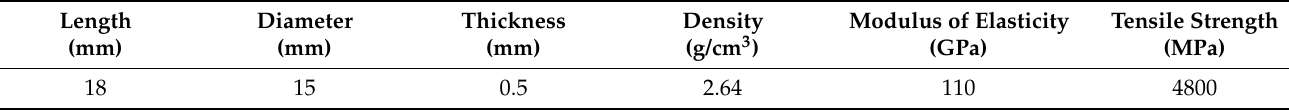
Table 7. Physical properties of basalt fiber. Table 8. Technical indicators of water-reducing agent.